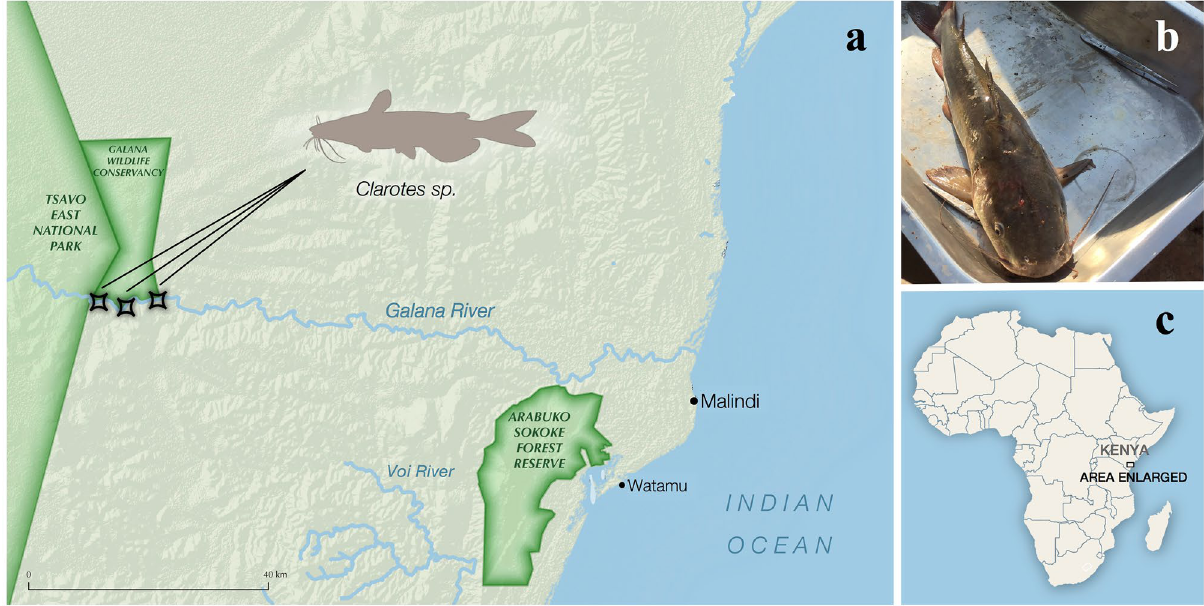
Figure 1. Locations where samples were collected. ( A ) Map showing were the fish were collected in South East Kenya. ( B ) Photograph of one of the widehead catfish provided by the scouts. ( C ) Map highlighting the location of the region shown in ( A ) on the African continent. Map generated using QGIS3.6 (https:// qgis. org/ en/ site/ forus ers/ downl oad.